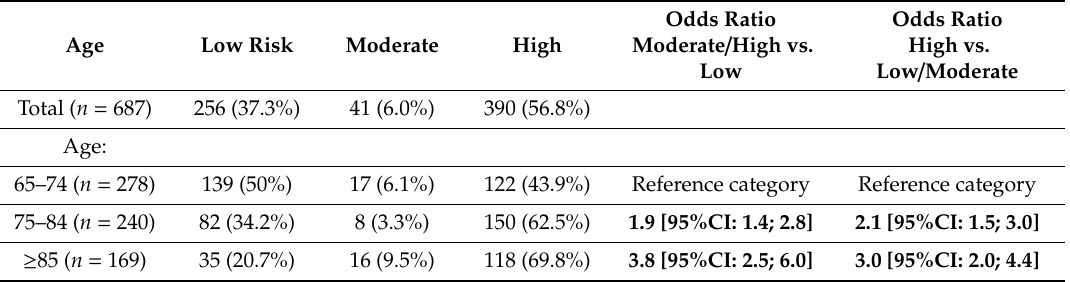
Table 3. Proportions ‘Short Nutritional Assessment Questionnaire for 65 + ’ (SNAQ) score and odds ratio’s compared between age categories.